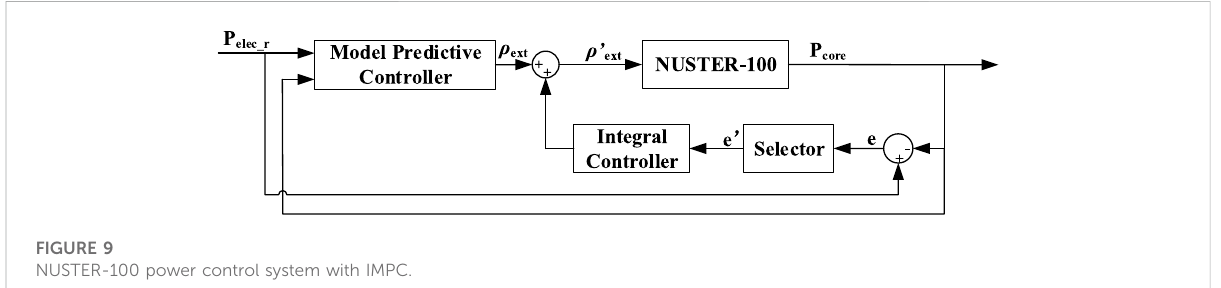
NUSTER-100 power control system with IMPC.